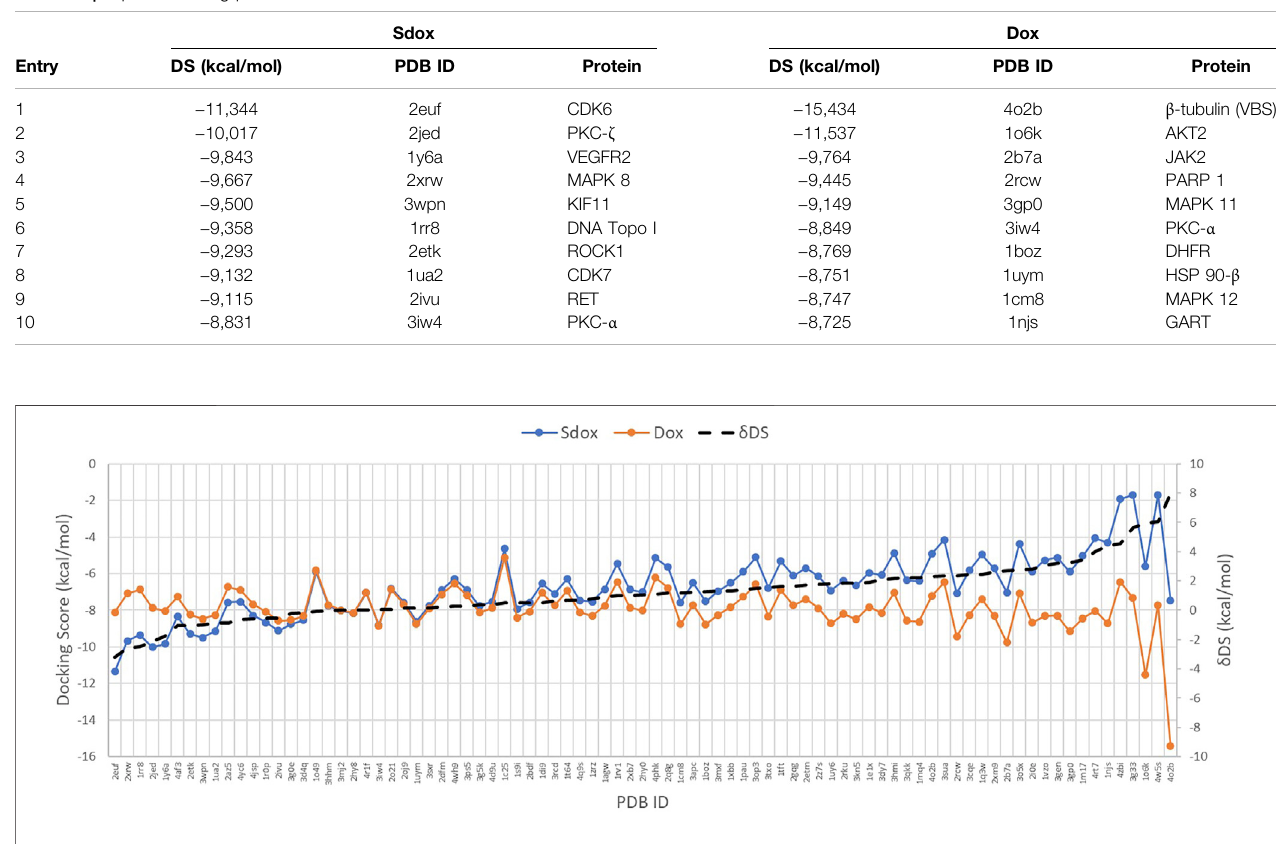
FIGURE 4 | Docking score of Sdox and Dox against 85 representative cancer